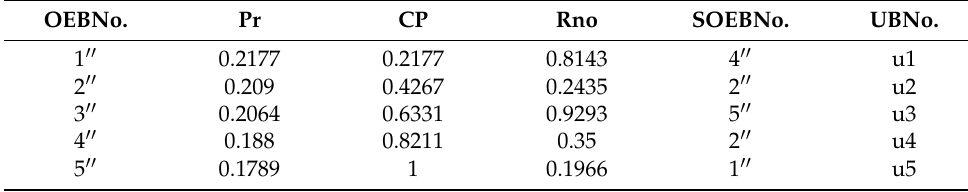
Table A11. Selection of unemployed bees ( UeNo ). OEBNo.